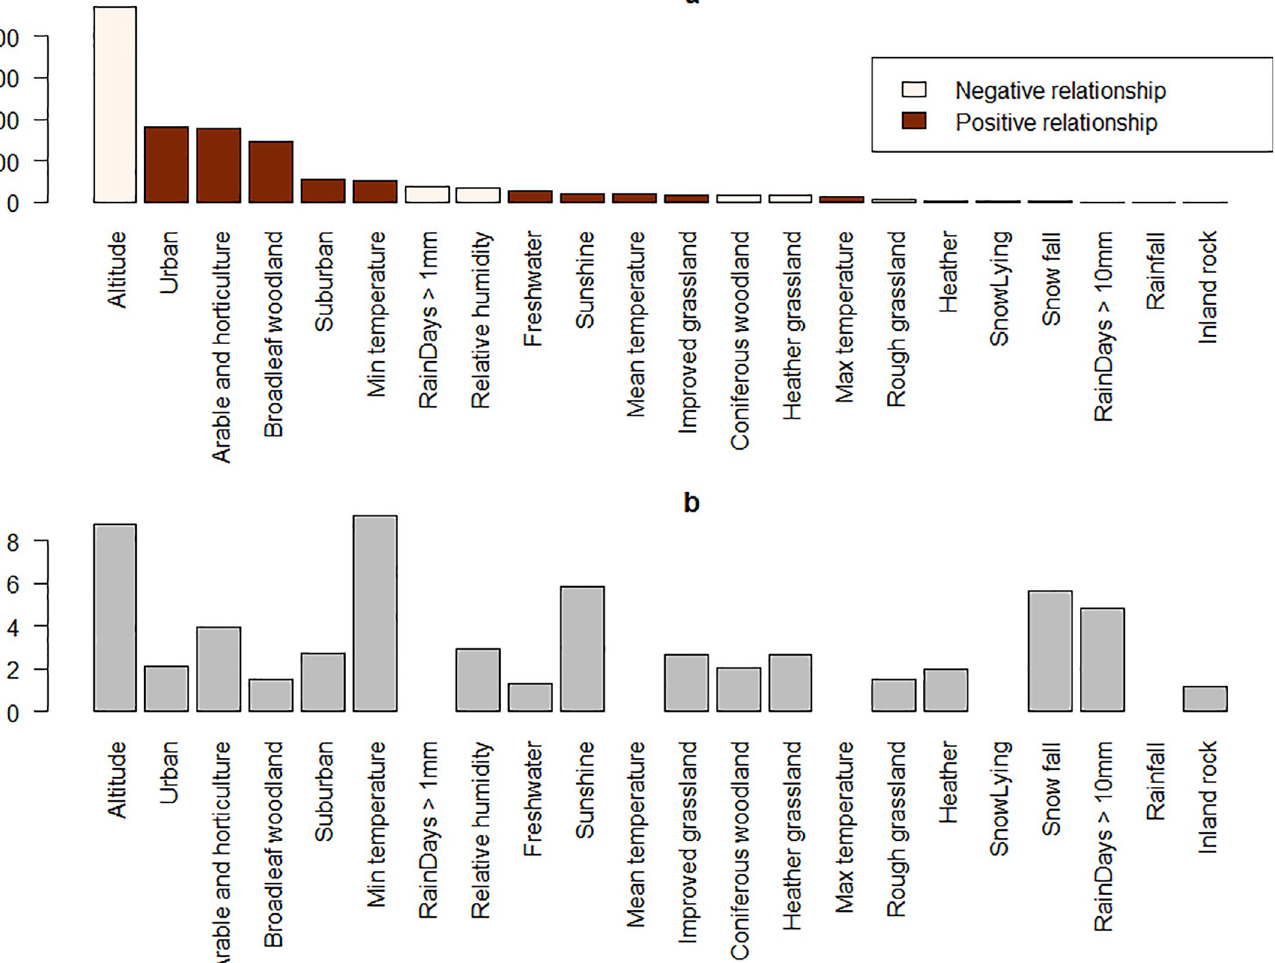
Fig 5. ANOVA analysis F value indicating relative importance of model predictors on consensus model values. (Fig 5A) Colour indicates direction of relationship between predictor and output. (Fig 5B) VIF values for model predictors, higher values indicate predictor less likely to be needed in the model, a value of 0 indicates that the variable was never chosen in the